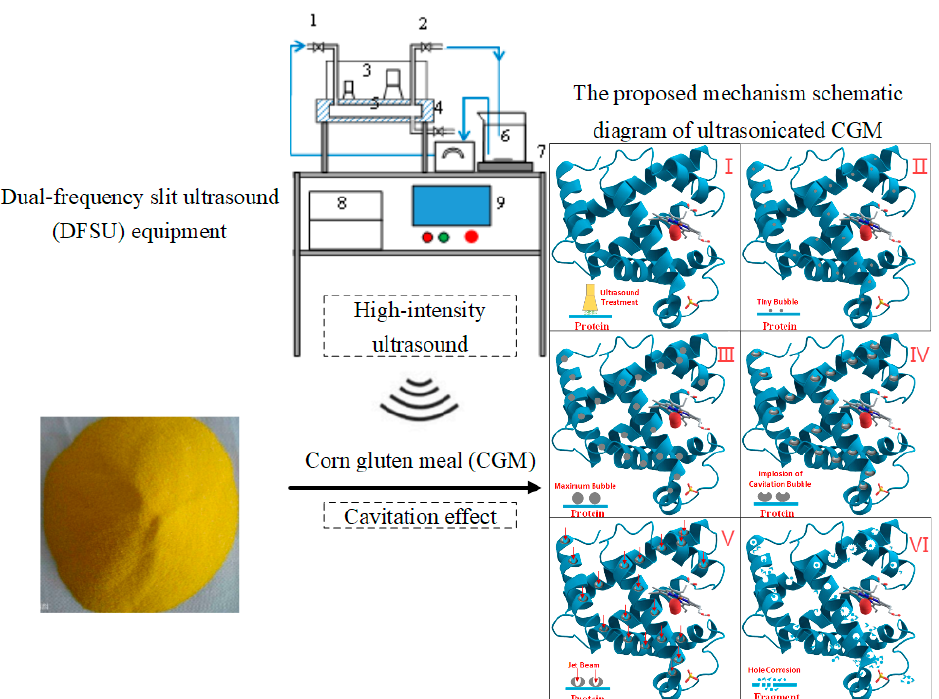
Figure 4. Diagram of the whole process of ultrasonically treated corn gluten meal (CGM) [41]. Note: The proposed mechanism schematic diagram of ultrasonicated CGM: (I)-Potein by ultrsound; (II)-Formation of tiny bubbles; (III)-Formation of cavitation bubbles; (IV)-Implosion of cavitation bubbles; (V)-Generation of jet beam; (VI)-Hole corrosion. Dual-frequency slit ultrasound (DFSU) equipment: 1. Sample inlet; 2. Sample outlet; 3. Ultrasonic transducer; 4. Waste outlet; 5. Slit cavity; 6. Treat liquid; 7. Magnetic stirrer; 8. Ultrasonic generator; 9. Programmable Logic Controller (PLC) control panel.